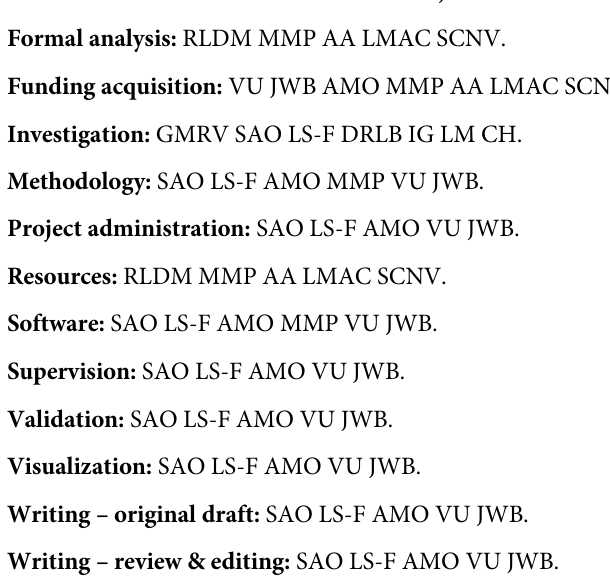
S1 Table. Meta data for all samples analyzed in this